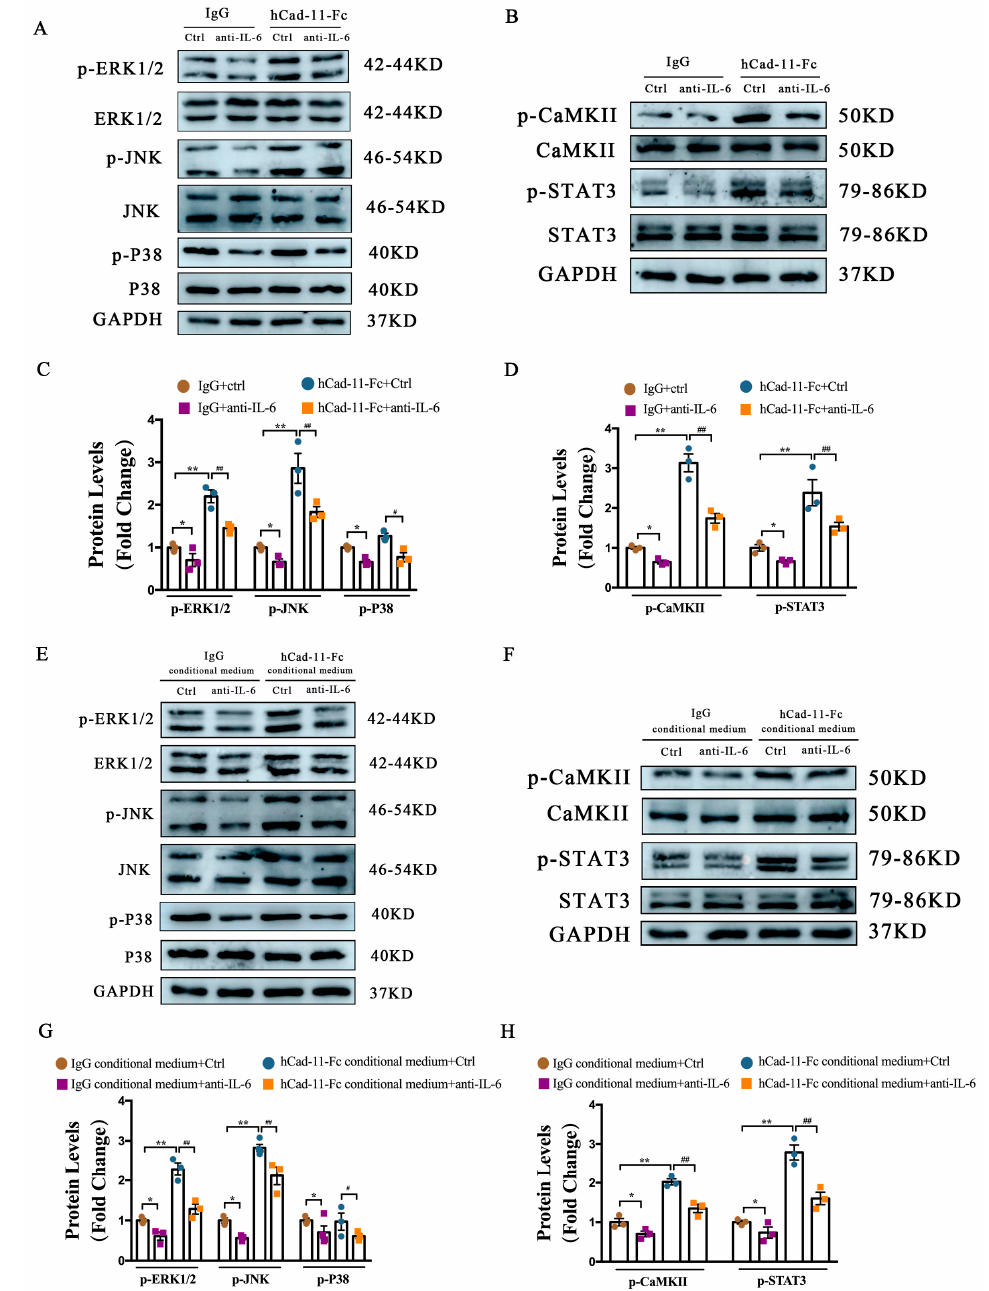
Figure 7. IL (interleukin)-6-activated MAPK and CaMKII–STAT3 pathways participate in Cad-11-induced cardiac fibroblasts activation and paracrine effect-induced cardiomyocyte hypertrophy. ( A – D ) Representative immunoblots and statistics showing phosphorylated ERK, JNK, P38 and phosphorylated CaMKII, STAT3 protein levels in neonatal mouse ventricular fibroblasts (CFs). The cells were pretreated for 30 min with or without anti-IL-6 antibody followed by incubation with IgG or hCad-11-Fc for 48 h ( n = 3 in each group). ( E – H ) Representative immunoblots and statistics showing phosphorylated ERK, JNK, P38, and phosphorylated CaMKII, STAT3 protein levels in neonatal mouse ventricular myocytes (NMVMs) pretreated for 30 min with or without anti-IL-6 antibody followed by incubation with the conditioned medium collected from CFs stimulated with IgG or hCad-11-Fc. Data were presented as mean ± SEM, * p < 0.05, ** p < 0.01 vs. IgG+Ctrl group, IgG conditional medium+Ctrl group. # p < 0.05, ## p < 0.01 vs. hCad-11-Fc + Ctrl group, hCad-11-Fc conditional medium + Ctrl